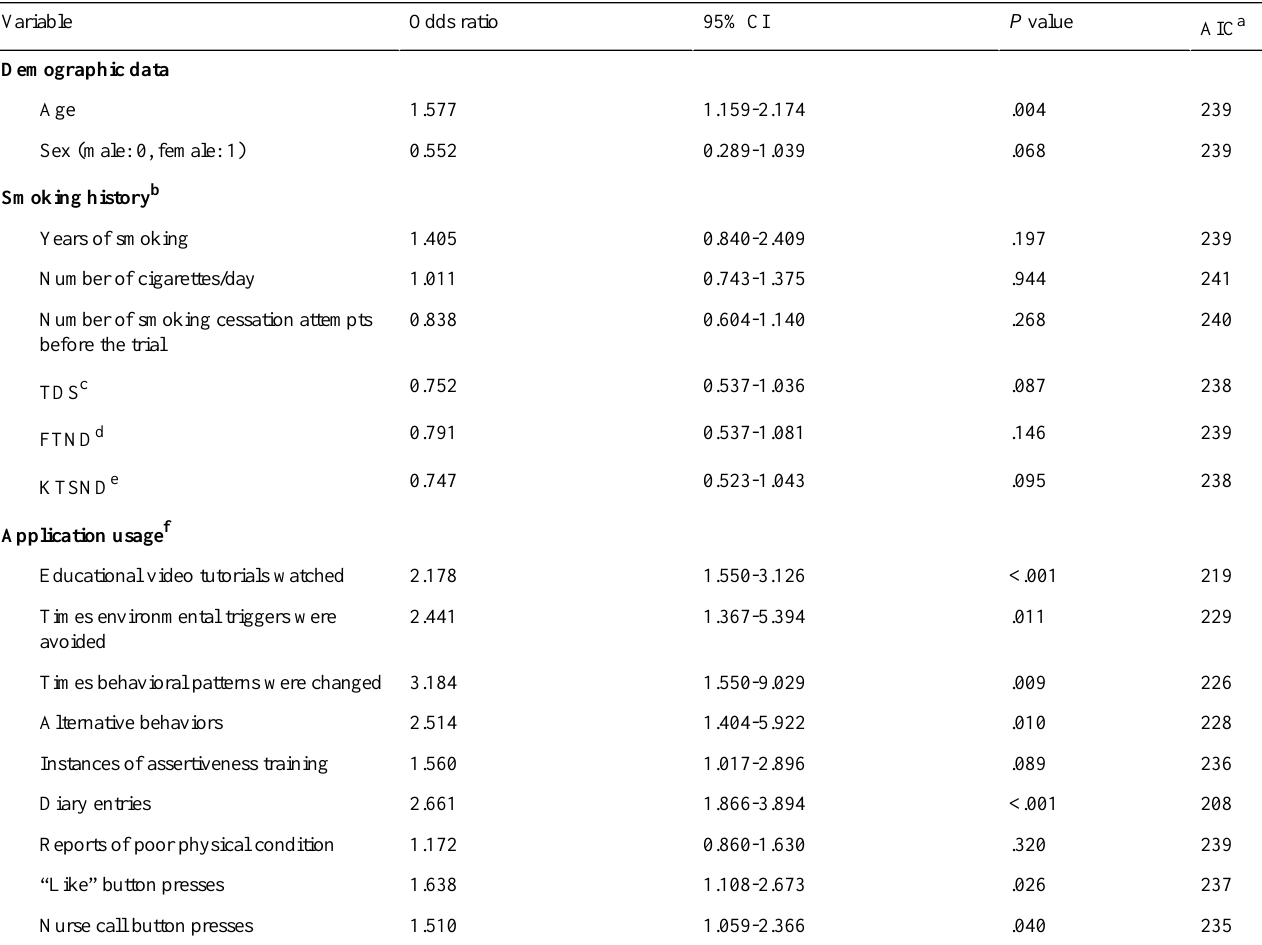
Table 3. Results of multivariable logistic regression analysis to determine potential predictors of smoking cessation success at week